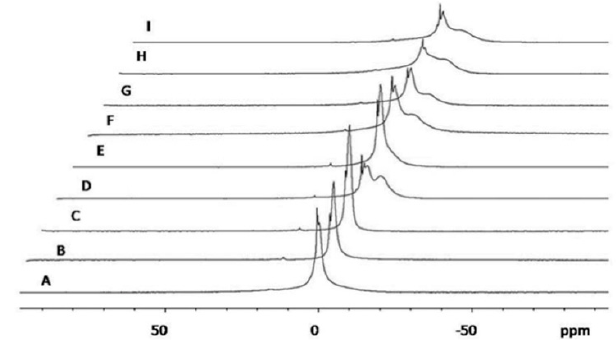
Figure 3. Representative spectra of empty liposomes ( A ), empty ( B ) and clotrimazole-loaded ( C ) 59:2 vesicles, empty ( D ) and clotrimazole-loaded ( E ) 53:10 vesicles, empty ( F ) and clotrimazole-loaded ( G ) 69:2 vesicles, and empty ( H ) and clotrimazole-loaded ( I ) 63:10 vesicles. Spectra are presented with a horizontal offset toward the right of 5 ppm to facilitate a clear view.